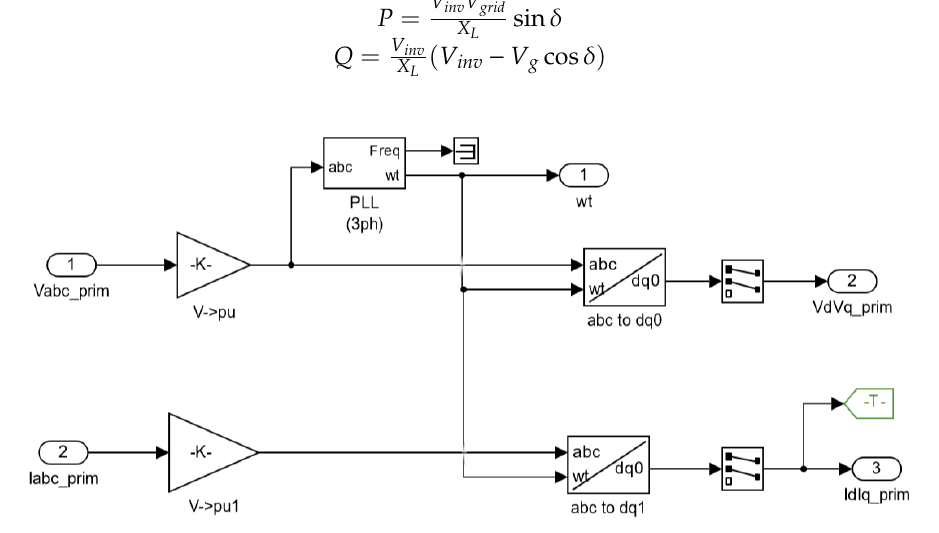
Figure 14. Phase-locked loop and dq 0 transformation.